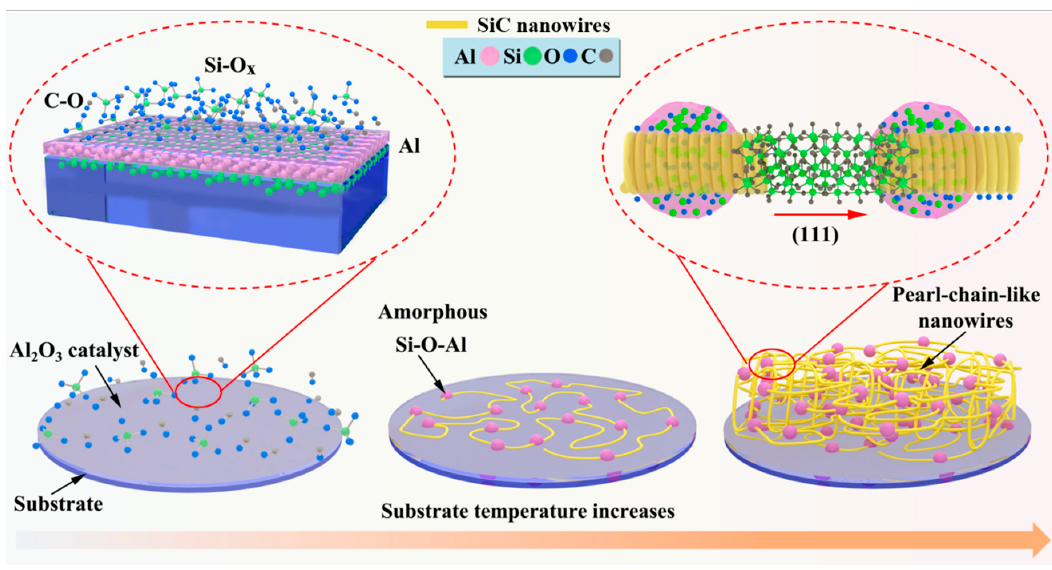
Figure 5. Schematic diagram of growth mechanisms of SiC nanowires loaded with Al 2 O 3